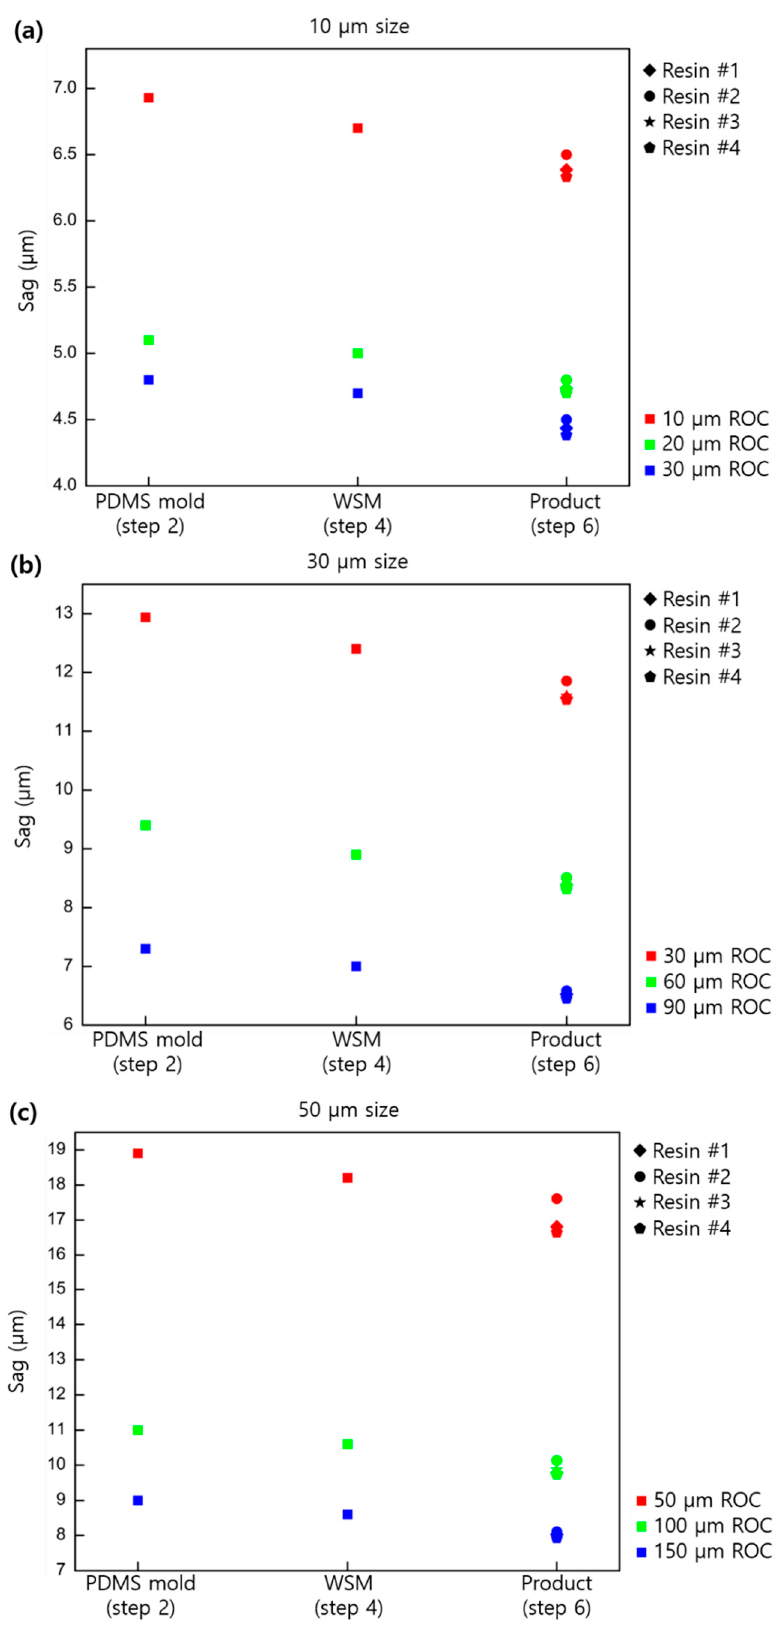
Figure 4. Sag profiles based on the lens size and shapes for the concave replicated samples: ( a ) 10, ( b ) 30, and ( c ) 50 µm in pitch.